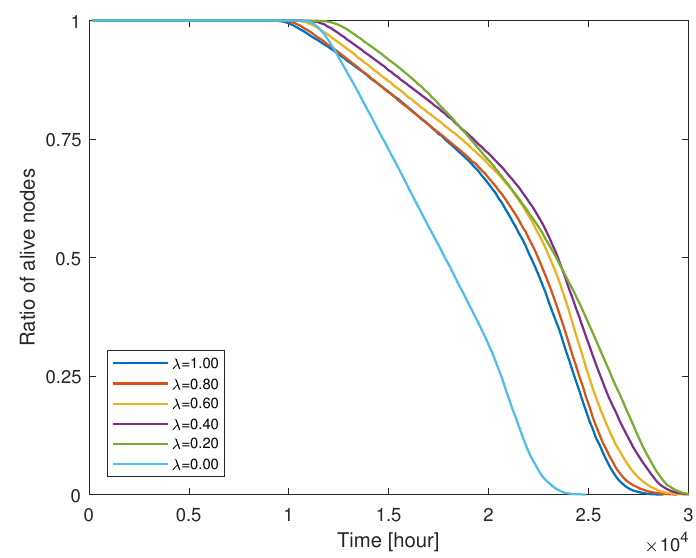
Figure 9. Measurements of live nodes per time for various λ configurations.